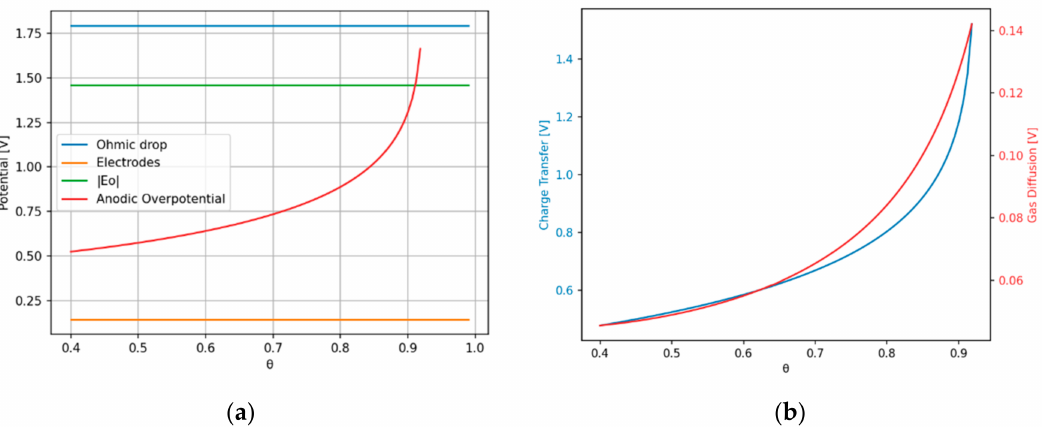
Figure 4. ( a ) Principal contributions to the overall cell voltage; ( b ) anodic overpotential due to charge transfer and gas diffusion.